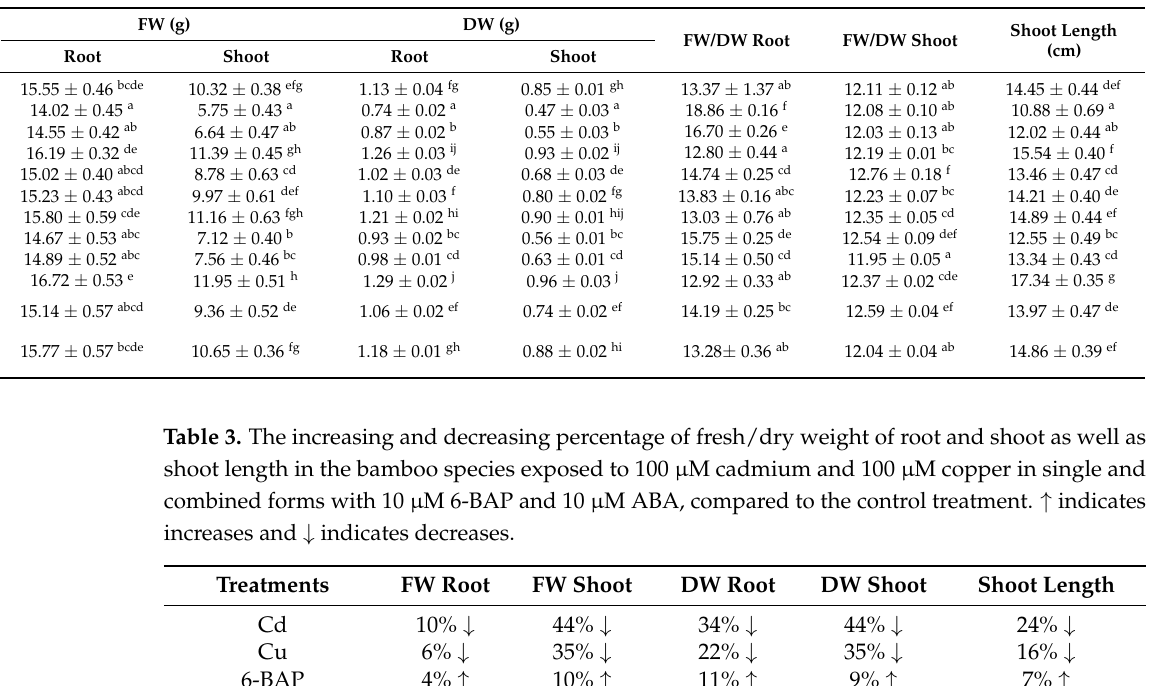
Table 2. The impact of 6-benzylaminopurine and abscisic acid, alone and in combination, on root fresh weight, root dry weight, shoot fresh weight, shoot dry weight, FW/DW in root, FW/DW in shoot and shoot length in the one-year-old Pleioblastus pygmaeus exposed to 100 µ M Cd and 100 µ M Cu. In this table, a–j letters revealed significant differences in the treatments of each index based on Tukey’s test ( p < 0.05).